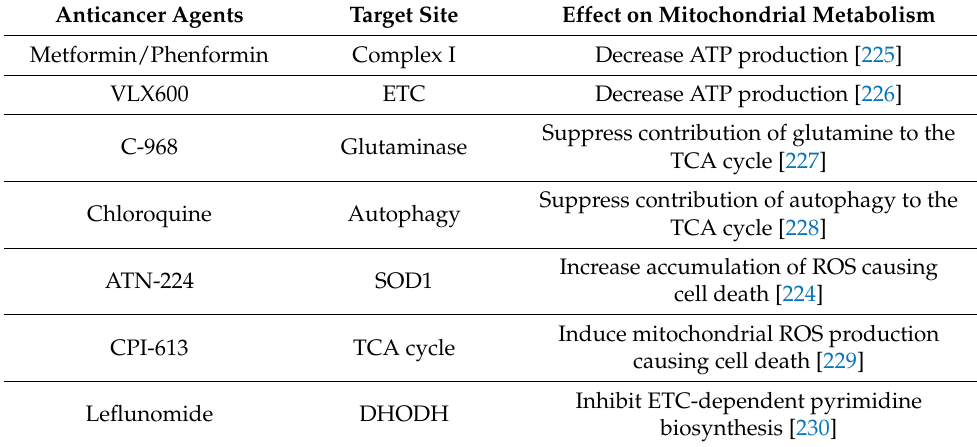
Table 2. Notable anticancer agents targeting mitochondrial